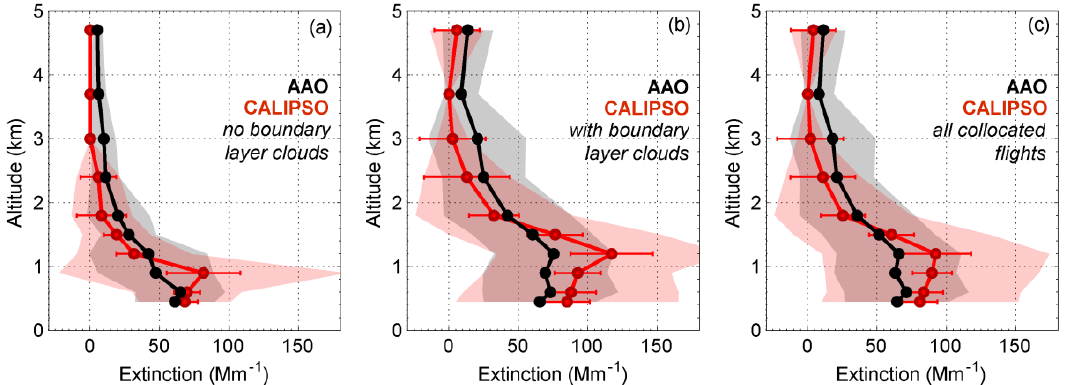
Fig. 14. Cumulative statistics of the mean extinction profiles of the 28 collocated in situ AAO and CALIPSO lidar comparisons. The shaded envelopes are standard deviations of the observations and the CALIPSO error bars are the propagated uncertainties of the lidar measurement. (a) No observed boundary layer clouds in proximal satellite track (8 cases). (b) Boundary layer clouds observed in proximal satellite track (20 cases). (c) All 28 collocated flights where CALIPSO retrieved extinction in the profile.